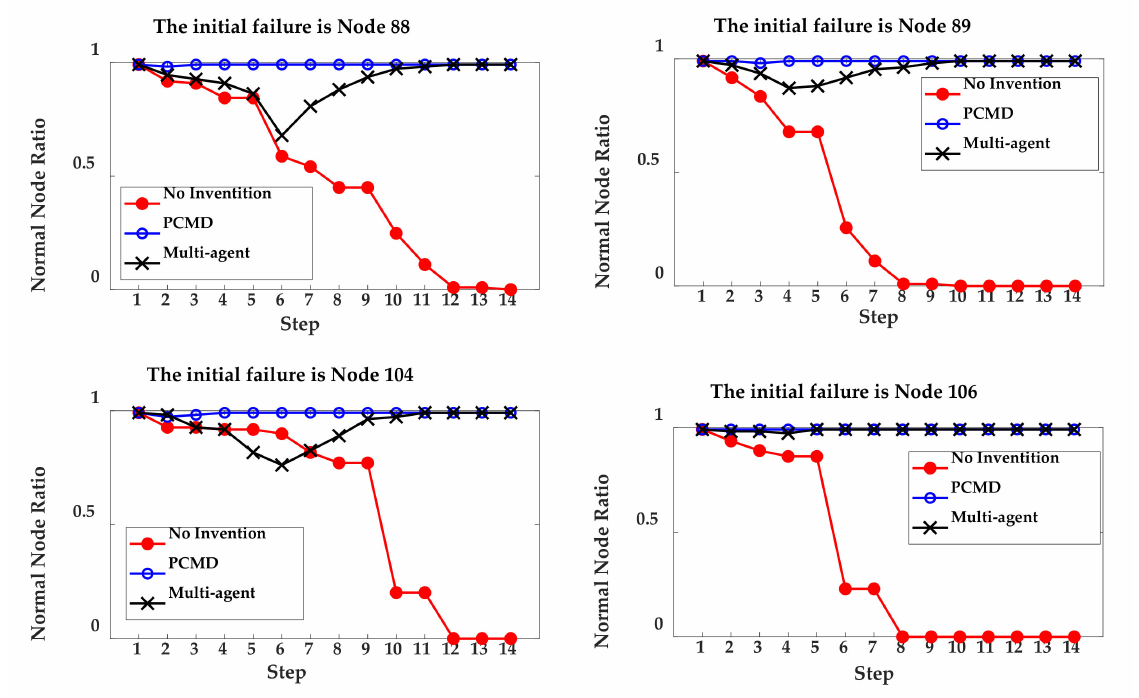
Figure 6. Comparison diagram of CCF initiated from a node failure in the